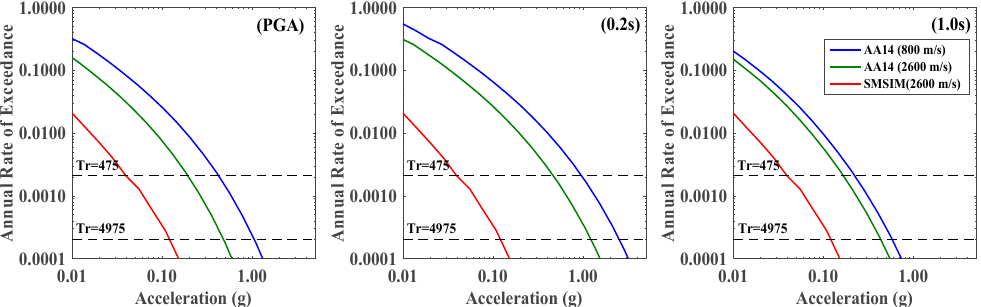
Figure 7. Hazard curves at the Euroseistest site for three different spectral periods (PGA, 0.2 s, 1.0 s), applying AA14 GMPE (blue for standard rock, green for hard rock—with HTT adjustments) or built from stochastic time histories on hard rock generated using SMSIM code (Vs = 2600 m/s, κ 0 = 0.024 s, Δσ = 30 ± 0.68 bars, CAF(f) from [26]).